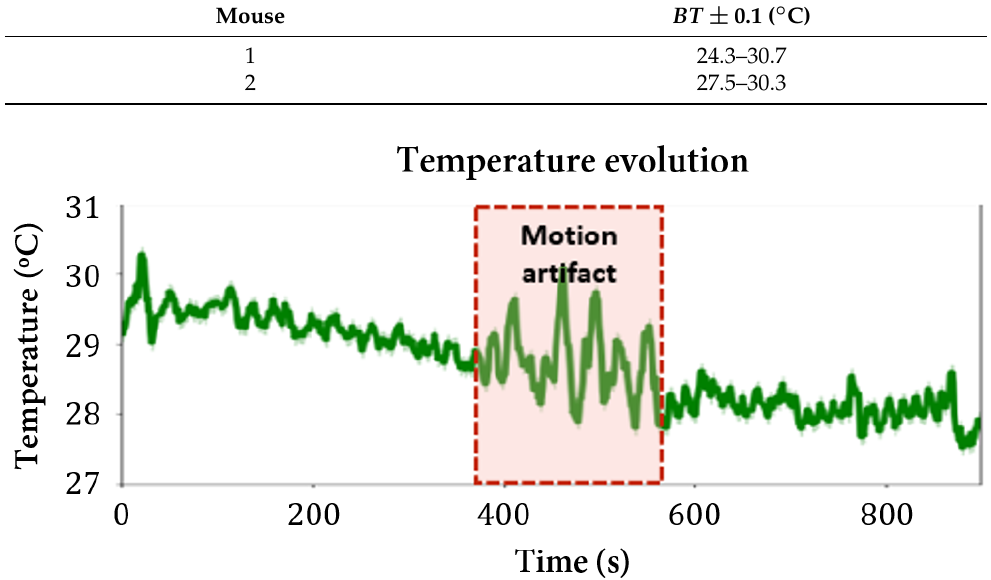
Figure 11. Mouse 2 temperature evolution. Of note is the downward tendency of temperature over time and the influence of motion artifacts in the